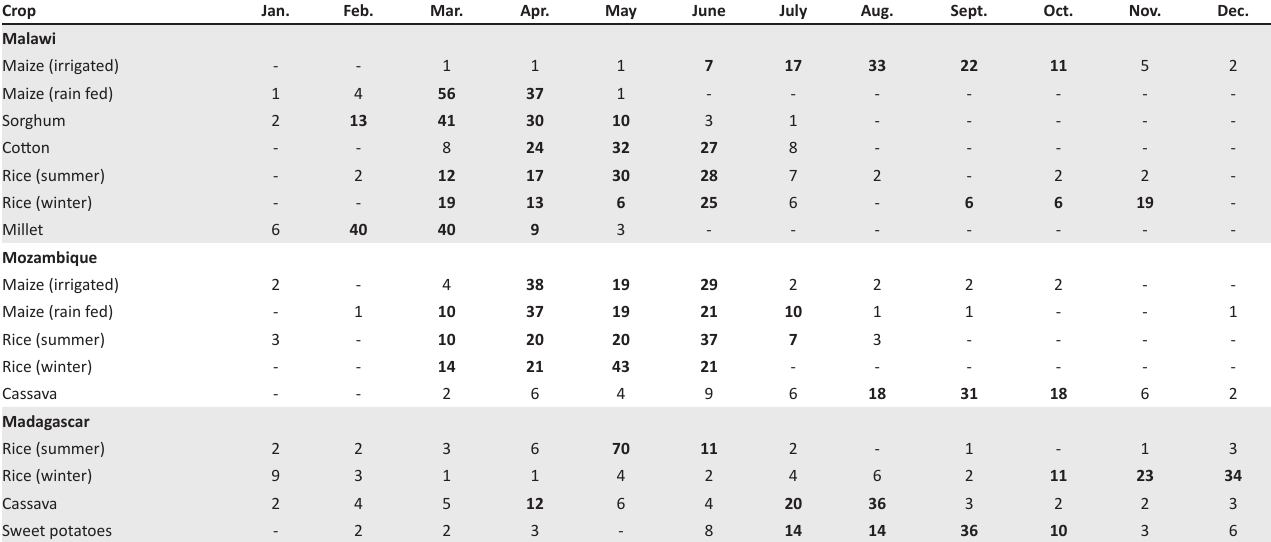
TABLE 2: Harvesting times (percentage of respondents).